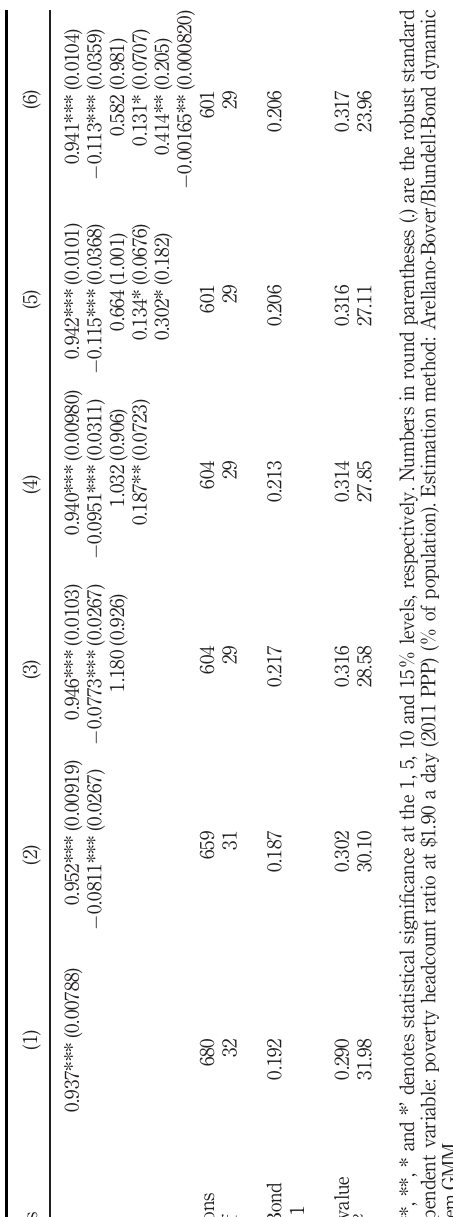
Table A5. Extreme poverty: the benchmark